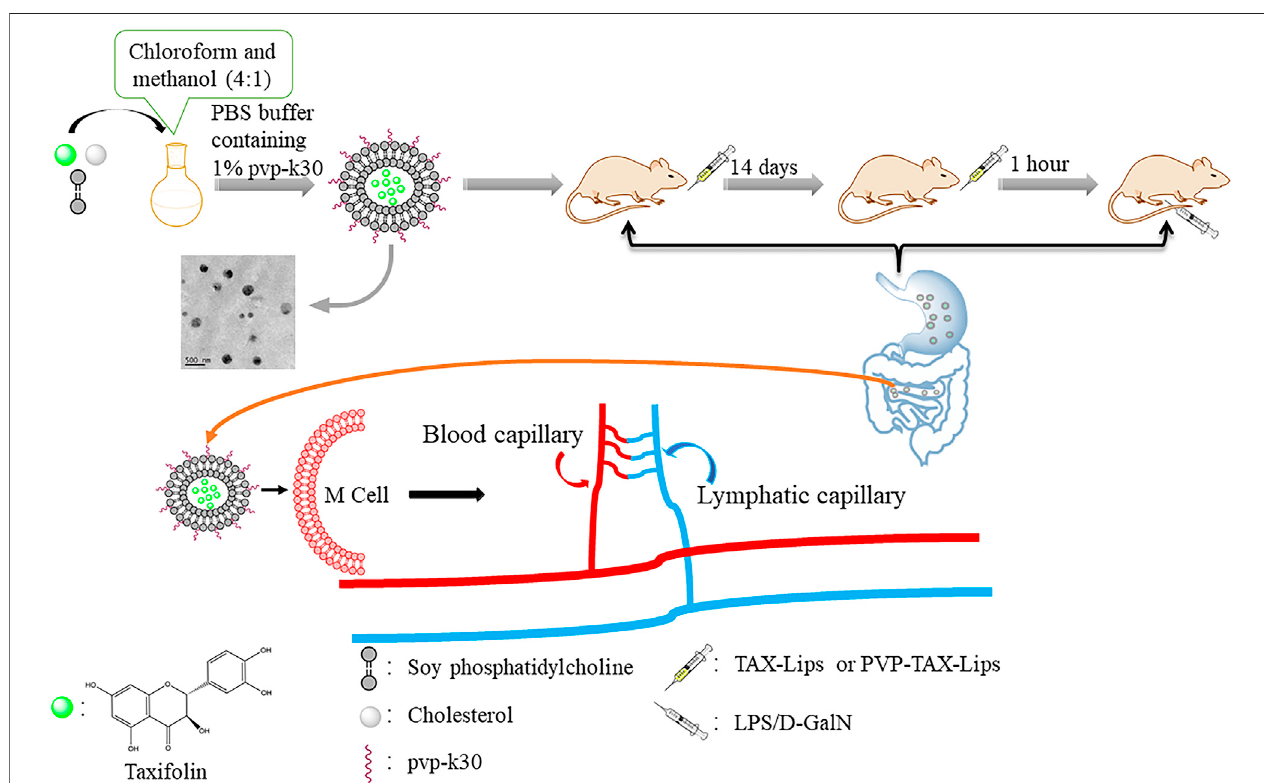
FIGURE 8 | The diagram of PVP-TAX-Lips oral administration into the body